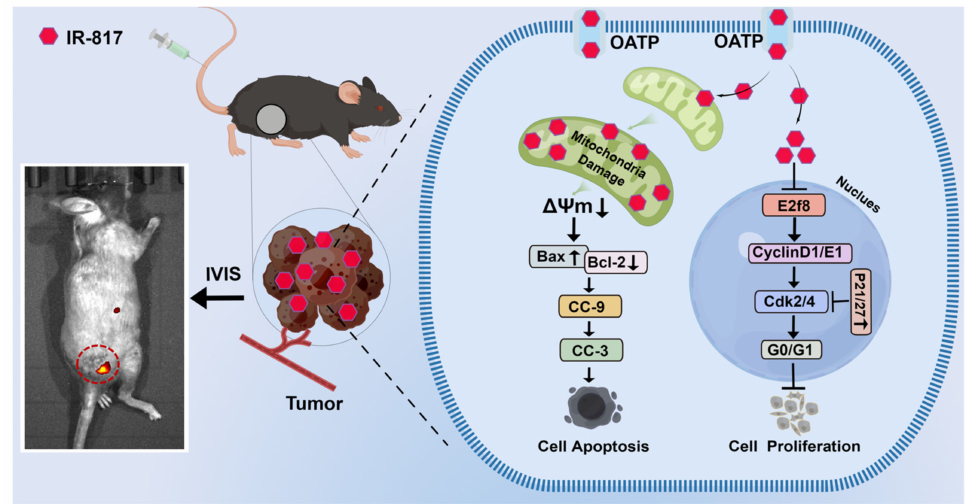
Scheme 1. Schematic illustration of IR-817 for diagnosis and treatment of tumor, including biomedical imaging effect and mechanism signaling pathway